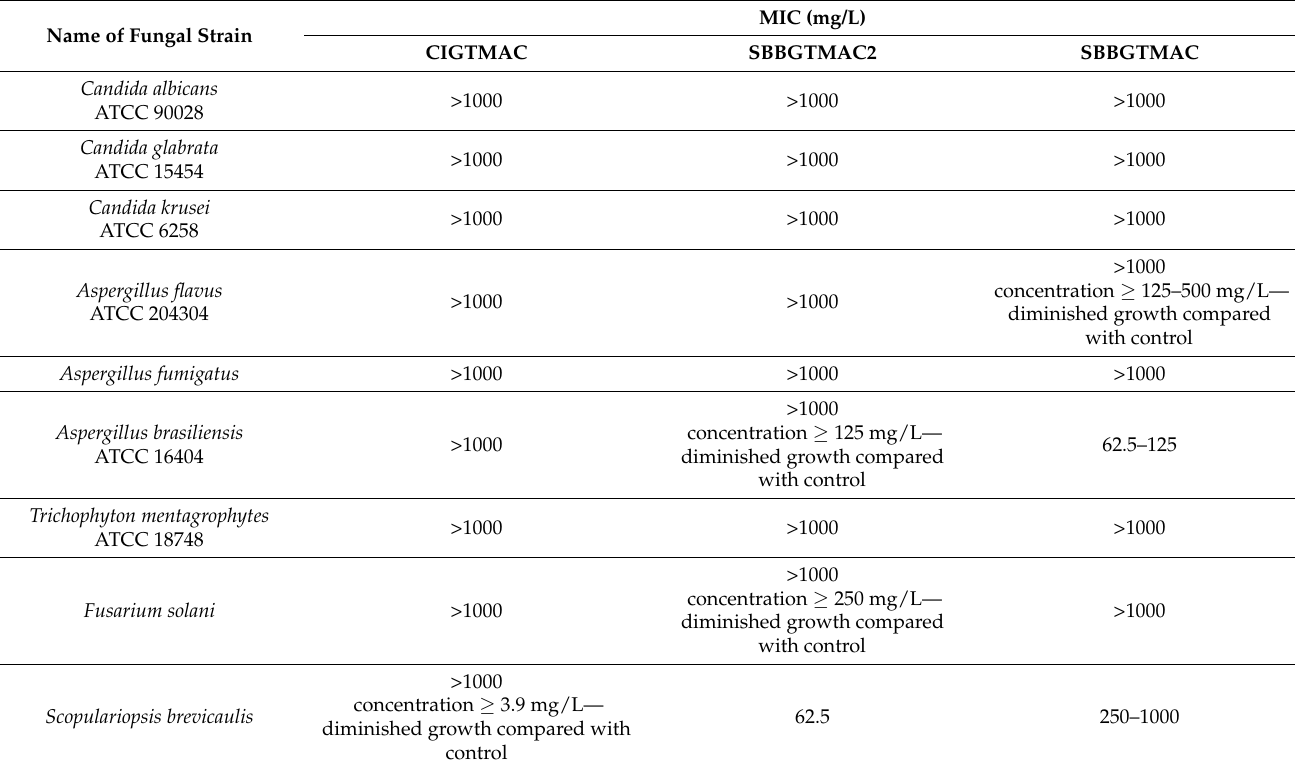
Table 4. MIC values (mg/L) for CIGTMAC, SBBGTMAC2, and SBBGTMAC against various fungal species. The results obtained from three replications are